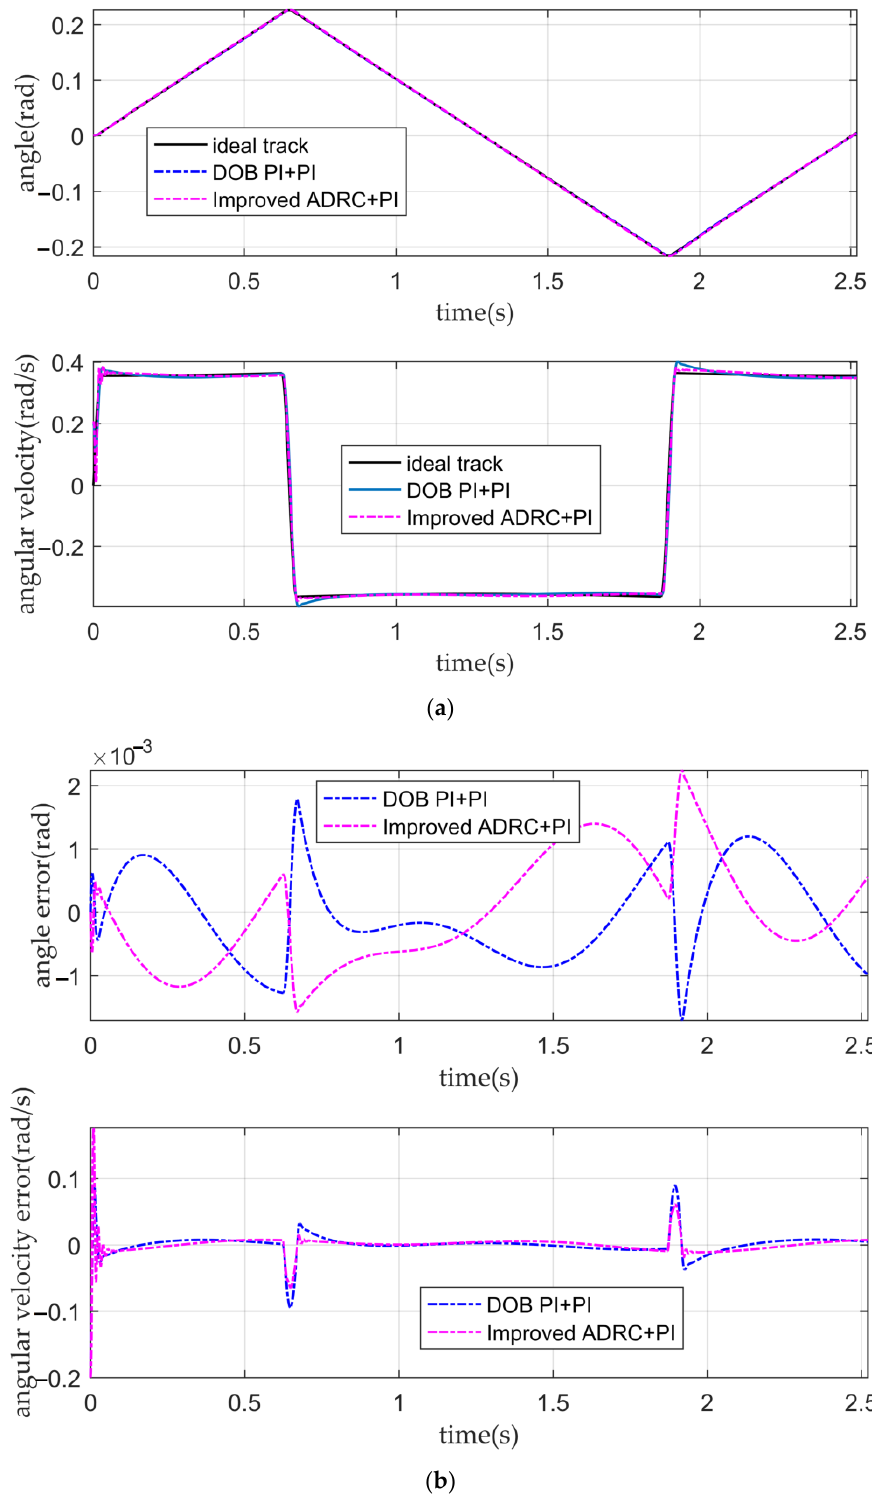
Figure 14. The tracking curves and the error curves . ( a ) The angular displacement tracking curves and the angular velocity tracking curves of the PI double closed-loop controller based on DOB and the IADR-DCLC; ( b ) the angular displacement error curves and the angular velocity error curves of the PI double closed-loop controller based on DOB and the IADR-DCLC.